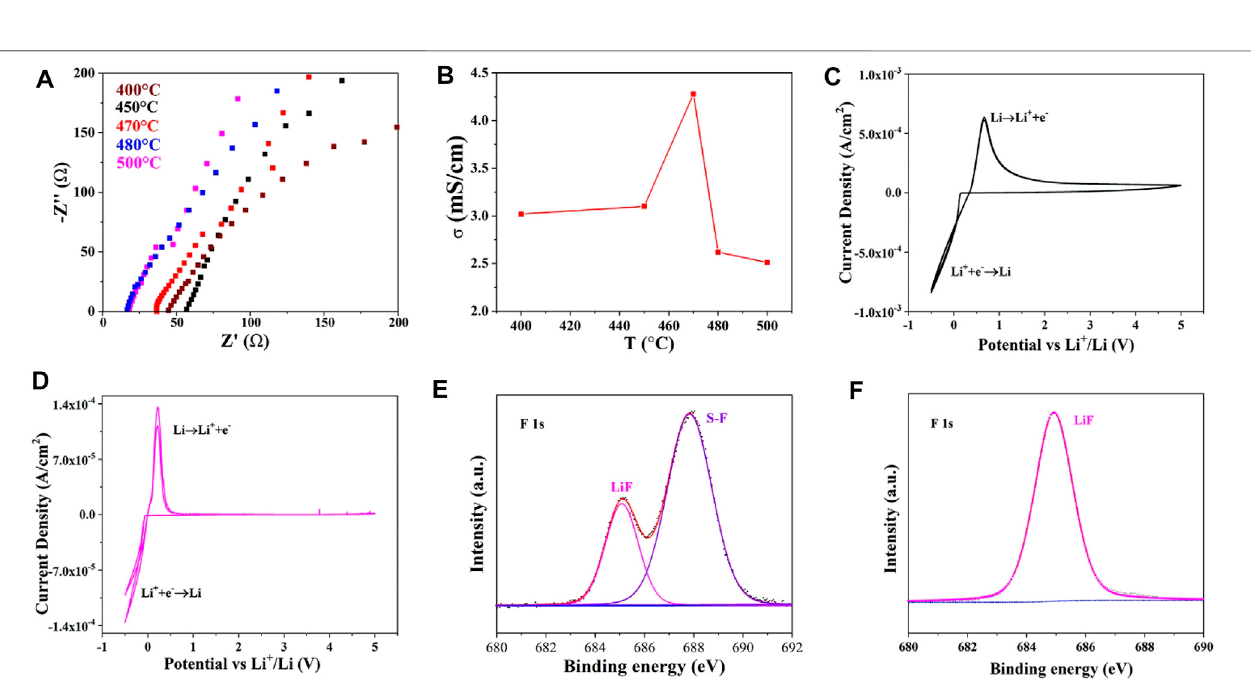
FIGURE 3 | Nyquist plots of Li 10.35 Si 1.35 P 1.65 S 12 synthesized at different temperatures (A) , the corresponding ionic conductivities (B) , CV test of Li 10.35 Si 1.35 P 1.65 S 12 with pristine lithium metal (C) and modi fi ed lithium metal (D) as electrodes, XPS of lithium metal before (E) and after (F) polarization